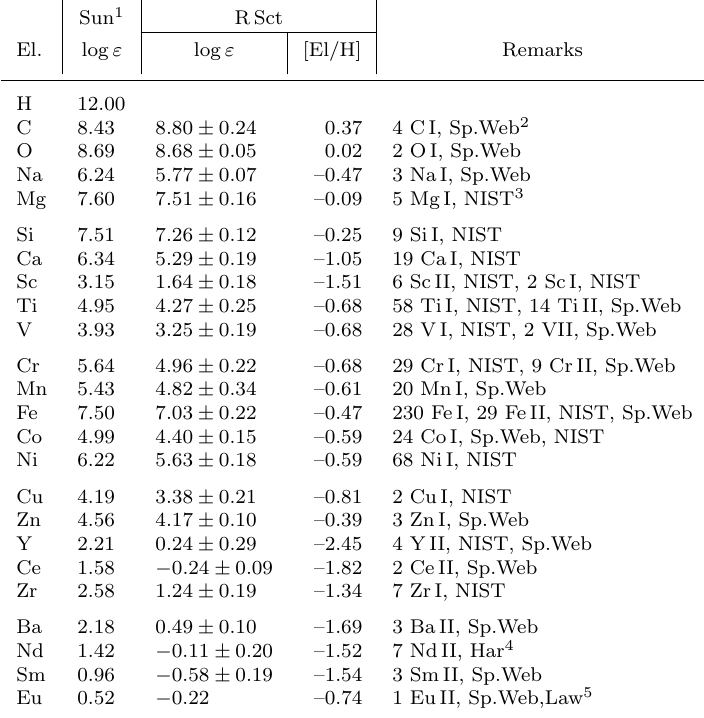
Table 2. Chemical composition of R Sct. The number of the used lines and the sources of oscillator strengths are indicated in